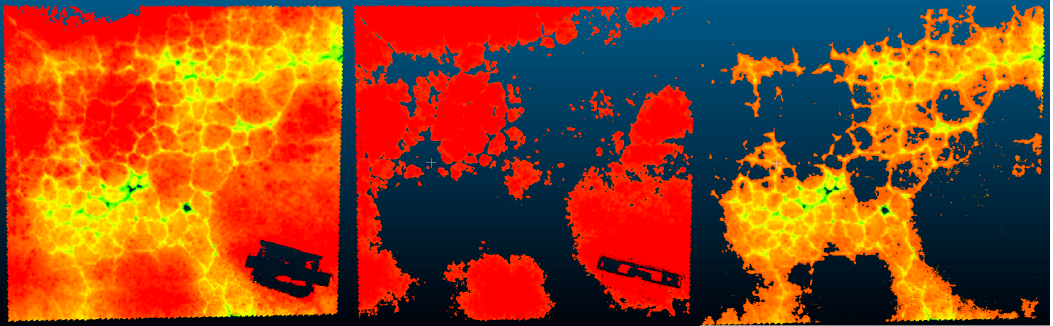
Figure 26. Segmentation of pavement section 2 using RANSAC.